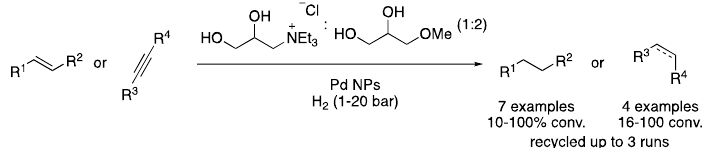
Figure 6. Pd-NPs-catalyzed hydrogenation of unsaturated compounds.